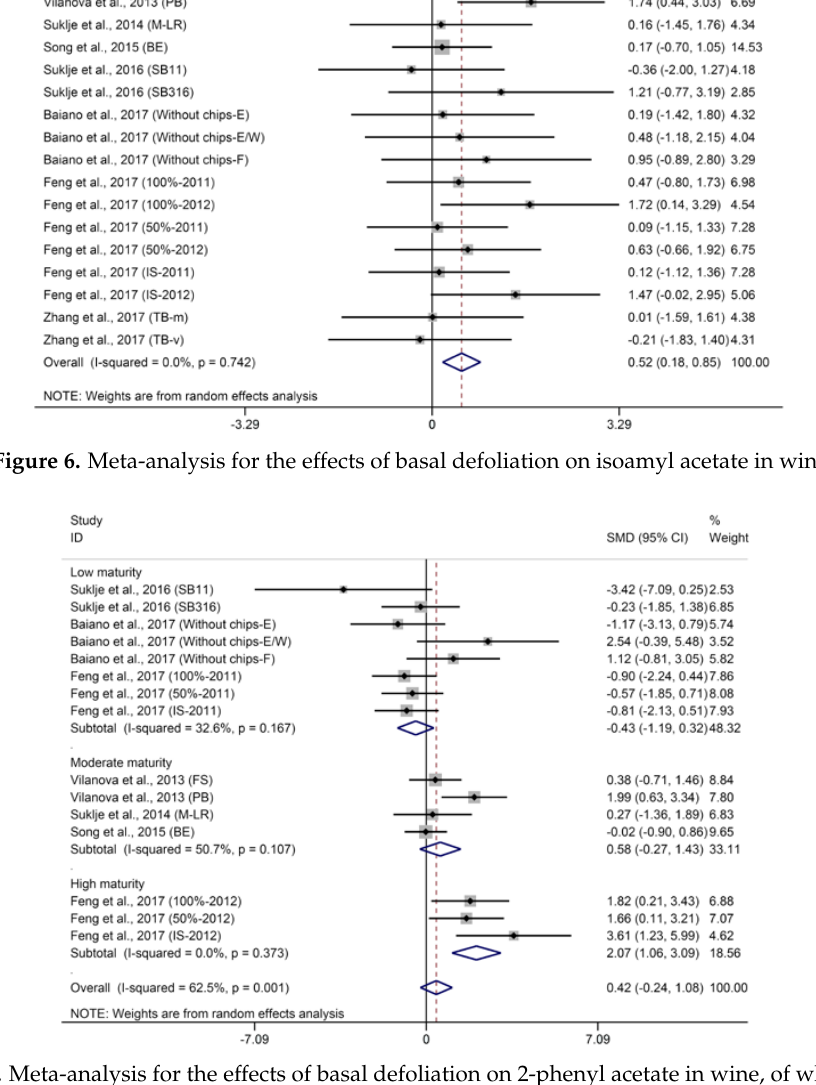
Figure 7. Meta-analysis for the effects of basal defoliation on 2-phenyl acetate in wine, of which